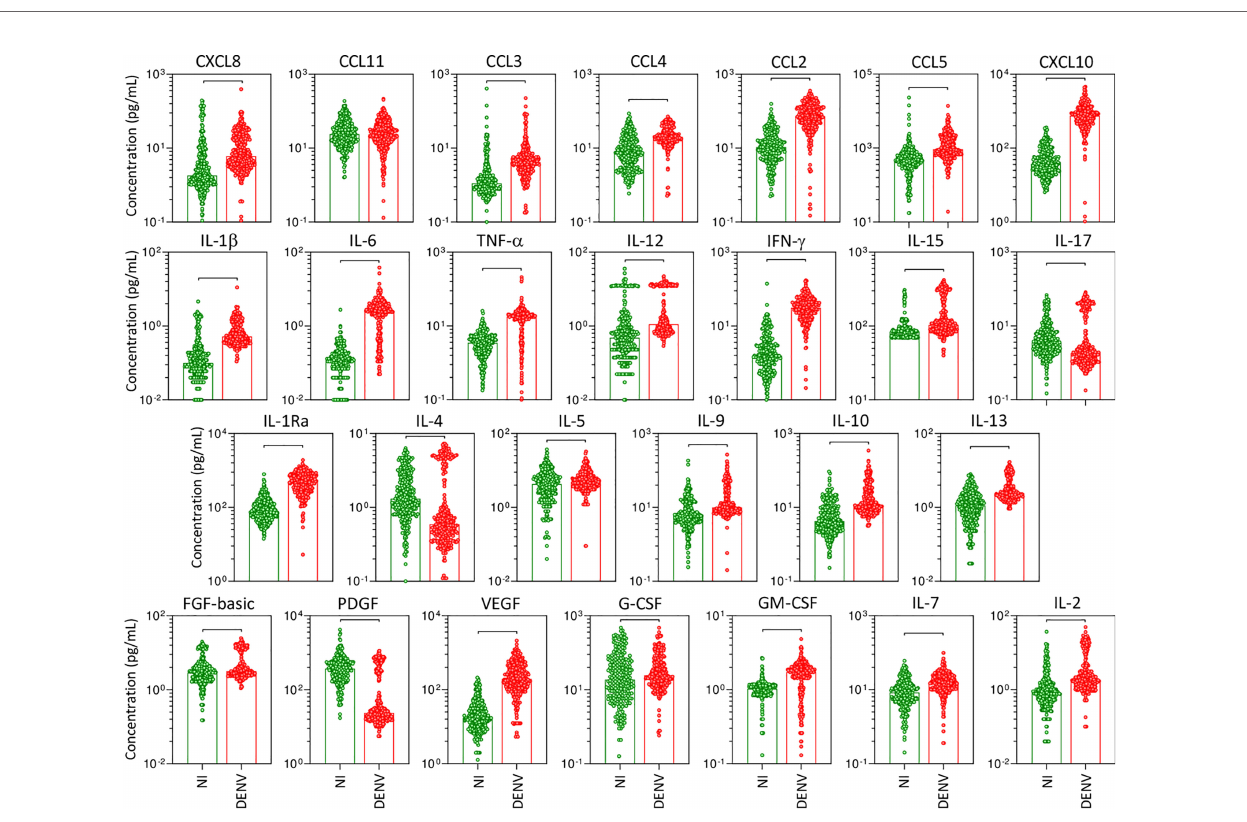
FIGURE 1 | Overall pro fi le of serum soluble mediators during acute DENV infection. The levels of chemokines (CXCL8, CCL11, CCL3, CCL4, CCL2, CCL5, CXCL10), pro-in fl ammatory cytokines (IL-1 b , IL-6, TNF- a , IL-12, IFN- g , IL-15, IL-17), regulatory cytokines (IL-1Ra, IL-4, IL-5, IL-9, IL-10, IL-13), and growth factors (FGF-basic, PDGF, VEGF, G-CSF, GM-CSF, IL-7, and IL-2) were measured in serum samples from patients with acute DENV infection – “ DENV ” ( n=317), represented by red dots/bars on the right side of each panel, as compared to the reference non-infected healthy controls – “ NI ” ( n=319), represented by green dots/bars on the left side of each panel. Quanti fi cation of serum soluble mediators was carried out by a high-throughput microbeads array as described in the Material and Methods section. The results are presented as the scattering of individual values expressed in pg/mL over bar plots highlighting the median on each bar. Signi fi cant differences at p <0.05 are indicated by connecting